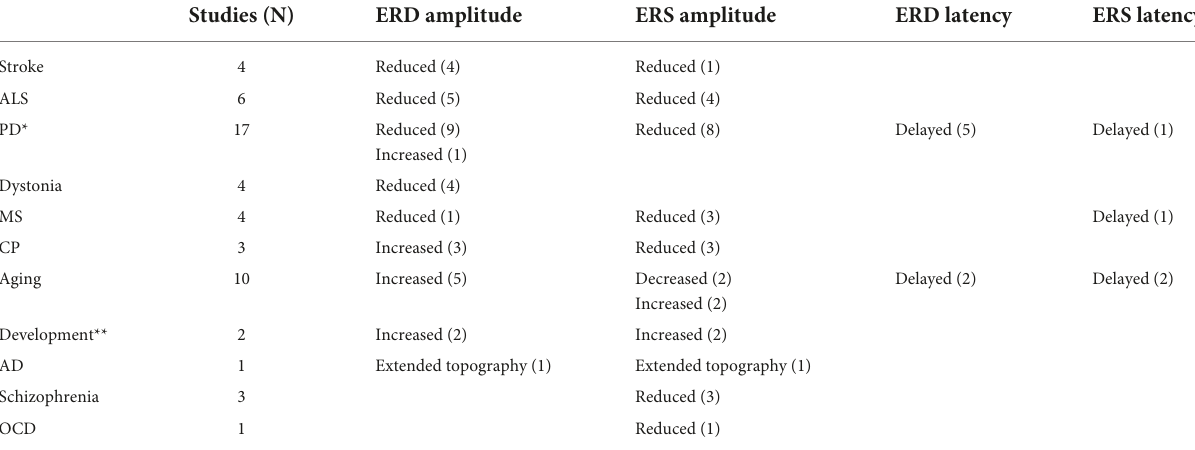
TABLE 5 Summary of the results of EEG and MEG studies in neuropsychiatric